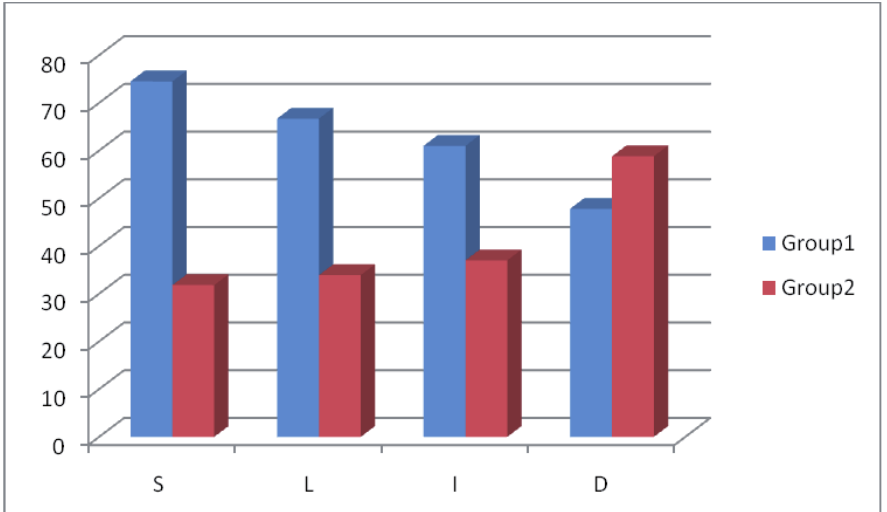
Fig.2 Mean indicators scale of “self-acceptance” (S), “acceptance of others” (L), “emo- tional comfort” (E), “internality” (I), “striving for dominance” (D) in the UTAL listeners group (gr.1) and in the elderly people group who do not